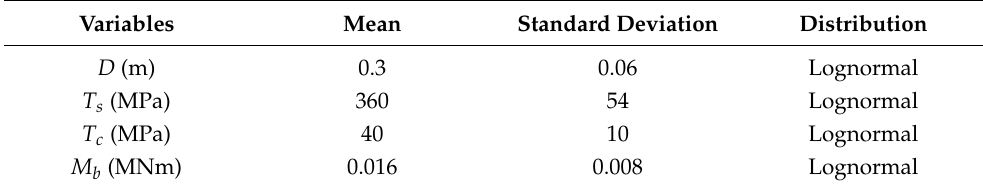
Table 3. Statistical information for the random variables in Example 2.